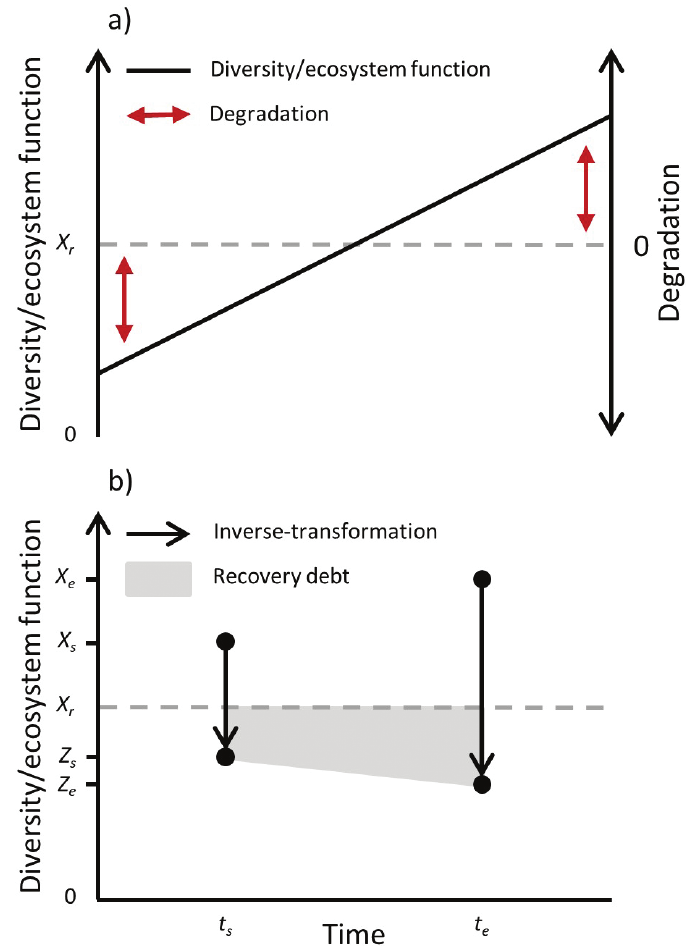
Figure 1. A schematic figure describing how degradation and the recovery debt are estimated in relation to undisturbed and disturbed ecosystem states. a) The difference between diversity/ecosystem function and the magnitude of degradation relative to an undisturbed natural state reference. While diversity/ ecosystem function can decrease or increase due to anthropogenic disturbance relative to the undisturbed reference state ( X , grey dashed line), both lower and higher values than the undisturbed reference state r can be considered degradation. It is worth noting, however, that while increase and decrease are neutral descriptors of change, by labelling any deviation from the natural state as degradation we are making a value statement that such change is undesired. b) The influence of the inverse-transformation on the diversity/ecosystem function values and recovery debt. The recovery debt sensu Moreno-Mateos et al. (2017) (the interim reduction of biodiversity and ecosystem functions lost during recovery compared to reference values) depends on the inverse-transformation Z of the original magnitude of degradation ( X ), s s the inverse-transformation Z of the state achieved during recovery ( X ), the time used for recovery ( t - t ), e e e s and the undisturbed reference state value ( X , grey dashed line). For simplicity, the undisturbed reference r state of the ecosystem ( X ) is depicted as a static line, although in reality each ecosystem type has a dynamic r mean natural state surrounded by some